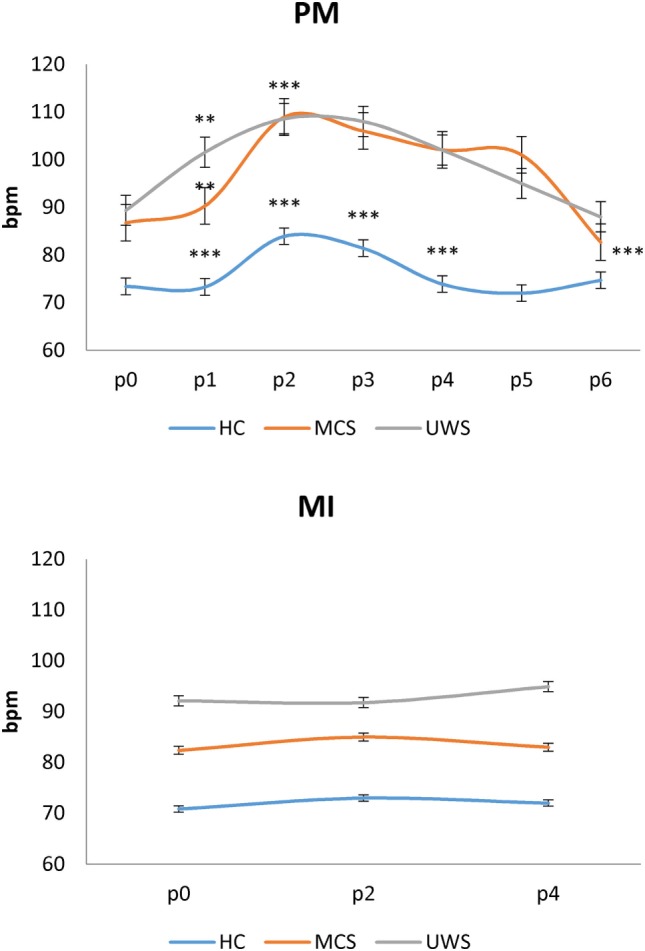
Shows mean (±SD; vertical error bar) heart rate values [in beats per minute (bpm)] during passive movement (PM) and motor imagery (MI) tasks for each group [healthy controls (HC), minimally conscious state (MCS), and unresponsive wakefulness syndrome (UWS)] across the hand positions (p) explored. There was a significant difference at p0 (baseline) between the bpm values of HCs and patients with disorders of consciousness (p < 0.001), and between patients with MCS and UWS (p = 0.01). PM induced a significantly different bpm modulation at each p among the groups (p < 0.001). On the contrary, MI did not induce any significant bpm change. *Refer to the significance of intragroup pulsatility index change at each p as compared to the previous one (Bonferroni corrected p-value, ***p < 0.001, **p = 0.001, *p < 0.0125).